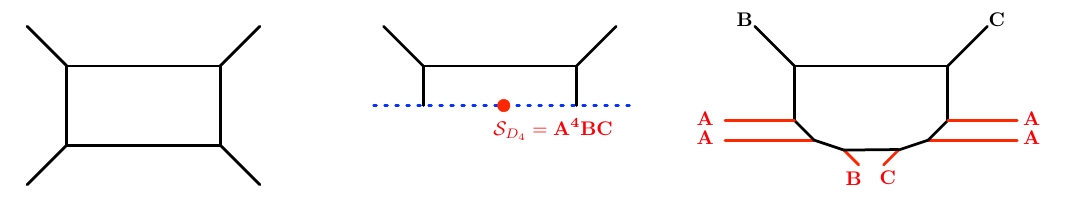
Figure 8 . The Z 2 fold of the 5d SU(2) 0 theory. It is to insert the 7-branes of D 4 singularity, = A 4 BC , at the fixed point of the Z S D 4 resulting 5-brane configuration is that of the SU(2) gauge theory with 4 flavors.